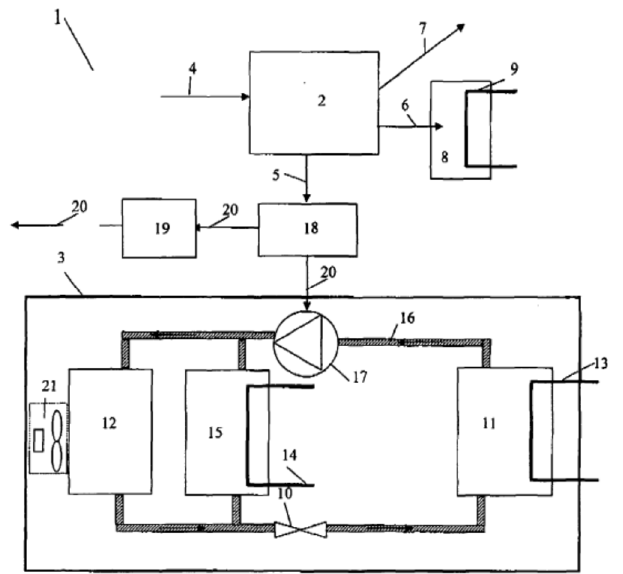
Figure 22. Schematic diagram of the patent of Mobile comfort holding (EP2085721).